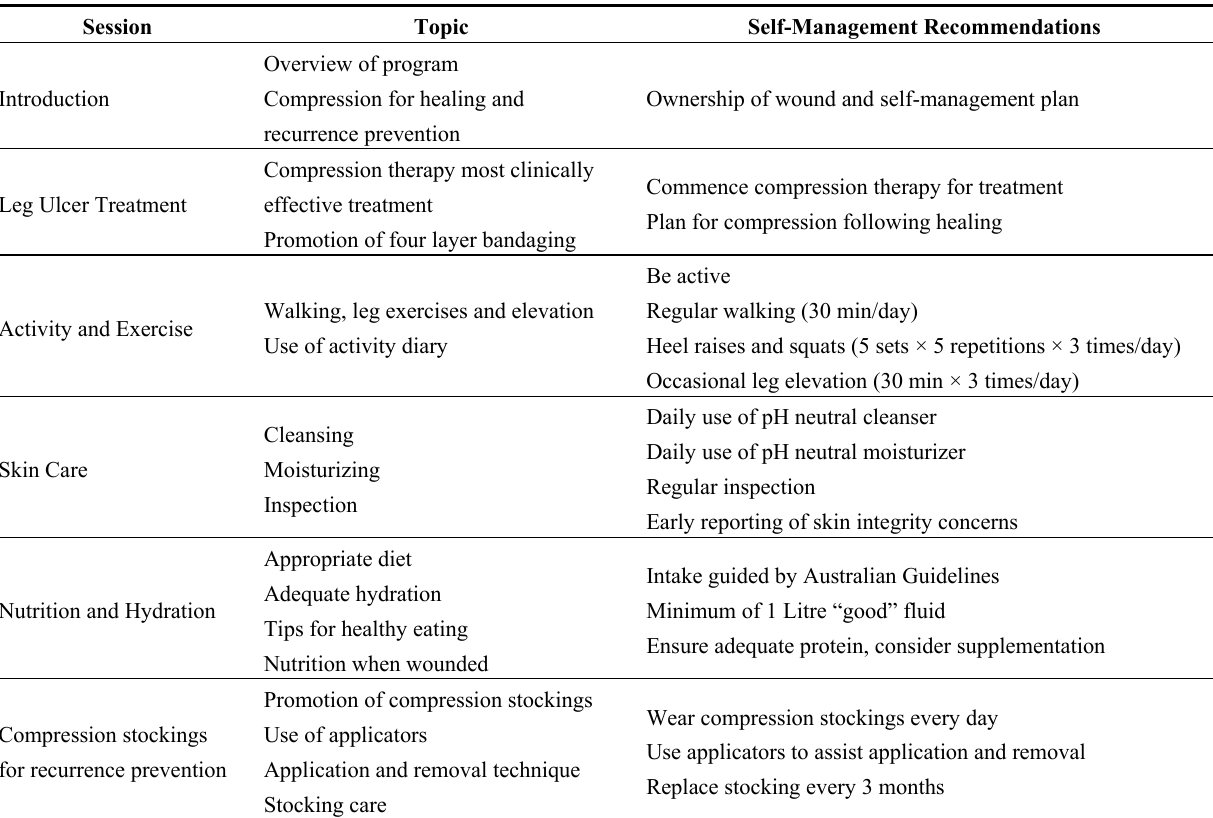
Table 1. Self-management recommendations for Leg Ulcer Prevention Program (LUPP)